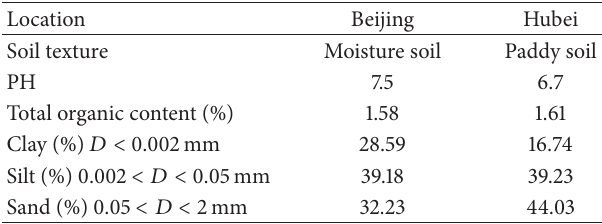
Table 1: Physicochemical properties of the two types of